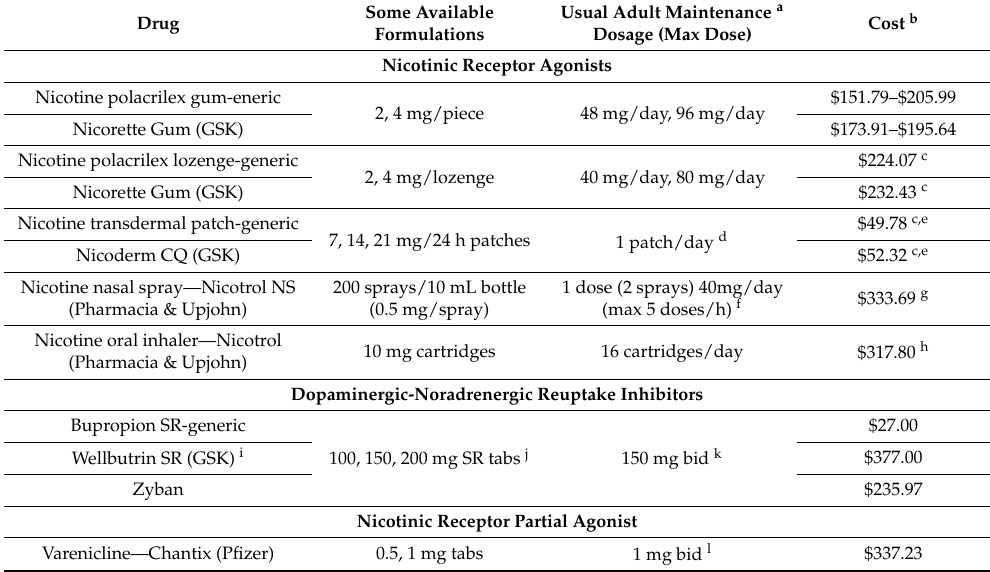
Table 7. Smoking cessation medications and cost